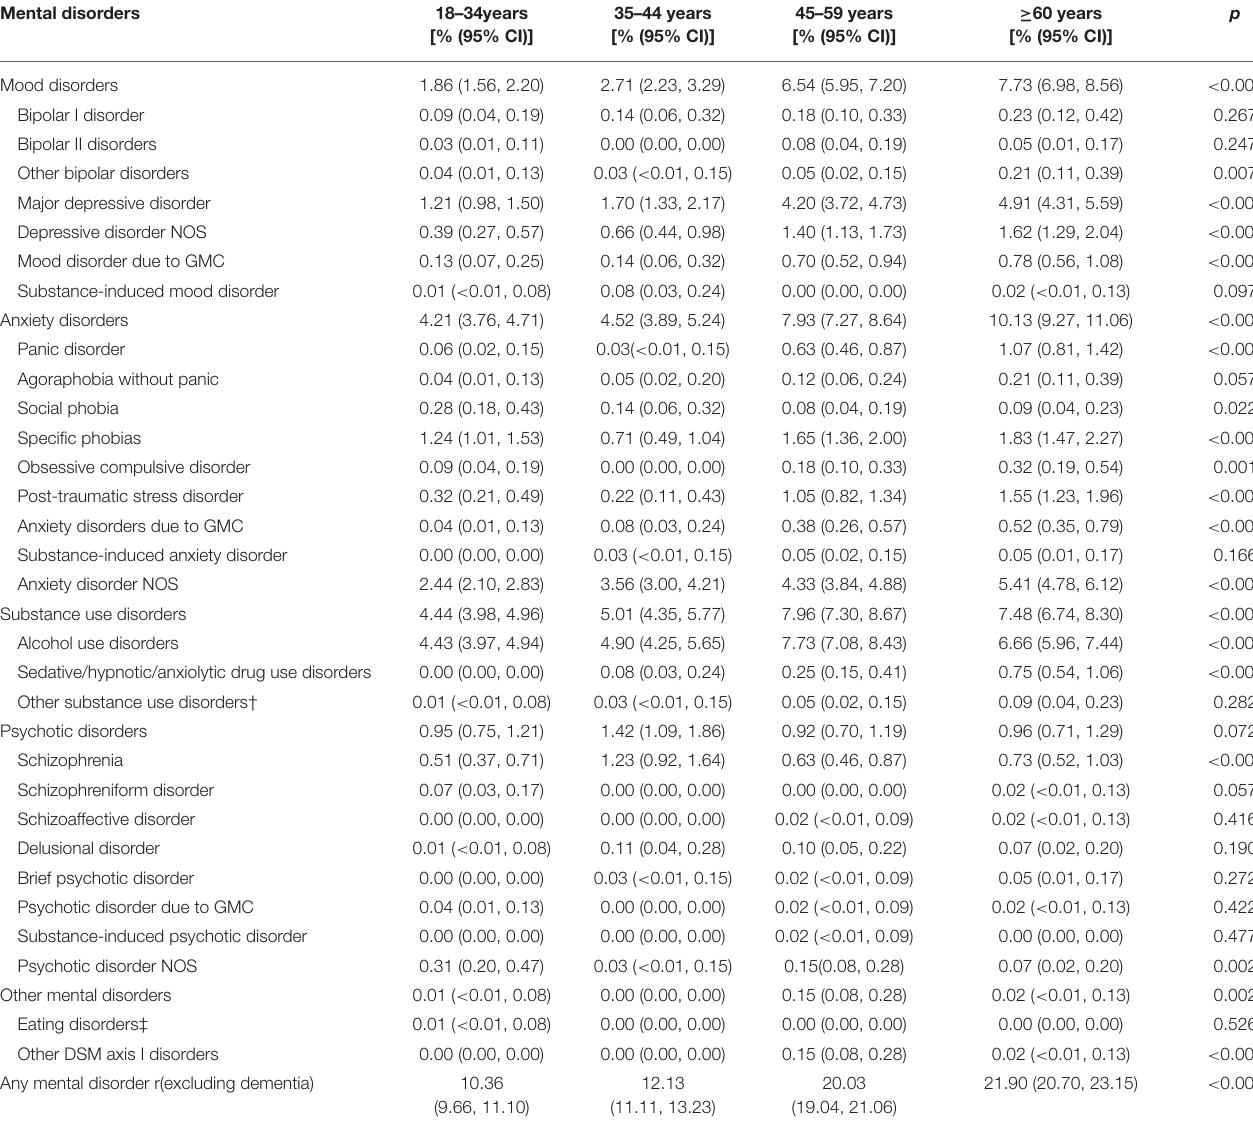
TABLE 4 | Weighted lifetime prevalence of mental disorders by age in Hebei province, China ( n =